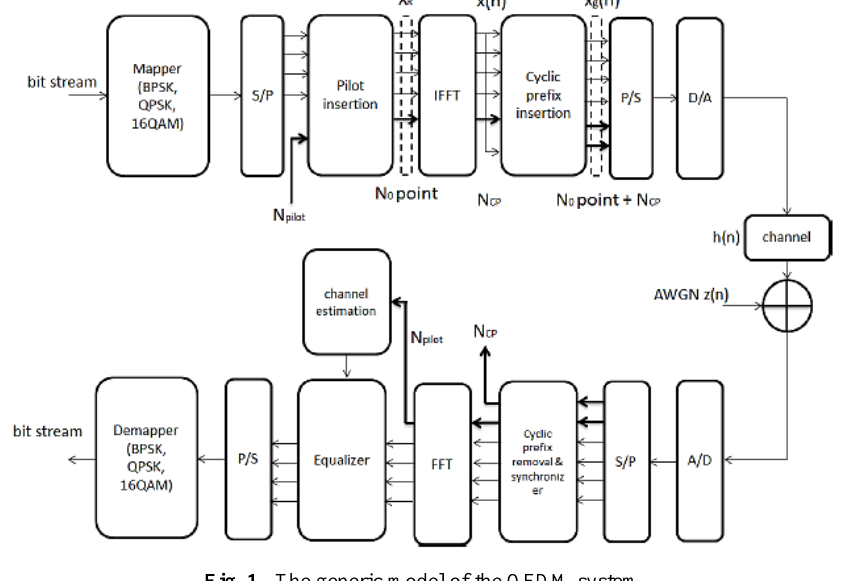
Fig. 1. The generic model of the OFDM